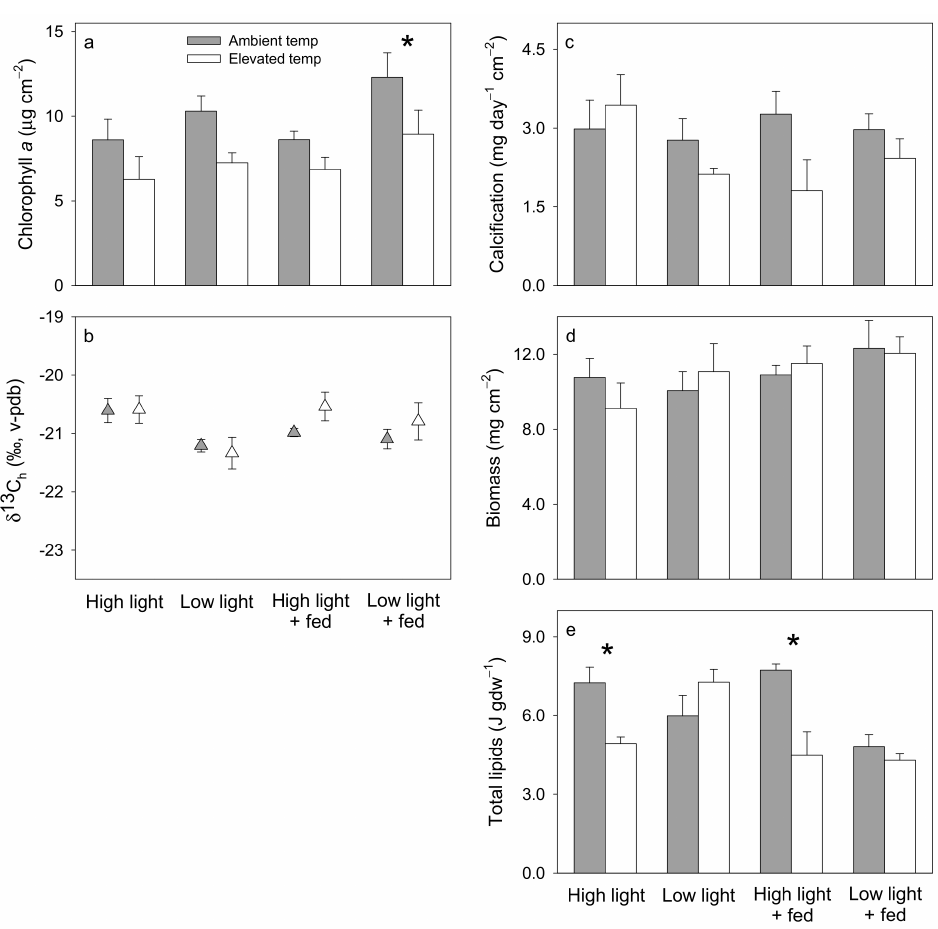
Figure 7. Turbinaria reniformis average ( ± 1 SE) ( a ) chlorophyll a , ( b ) δ 13 C h , ( c ) calcification, ( d ) biomass, and ( e ) total lipids, under ambient temperature (25 ◦ C, solid bars) and elevated tempera- ture (30 ◦ C, open bars) within high light (300 µ mol photons m − 2 s − 1 , unfed), low light (150 µ mol photons m − 2 s − 1 , unfed), high light + fed (300 µ mol photons m − 2 s − 1 , fed), and low light + fed (150 µ mol photons m − 2 s − 1 , fed) treatments. Asterisks indicate significant differences between ambient and elevated temperature treatments within each light and feeding treatment combination. N = 4–5 for all averages. Significant effects from corresponding ANOVAs in Table